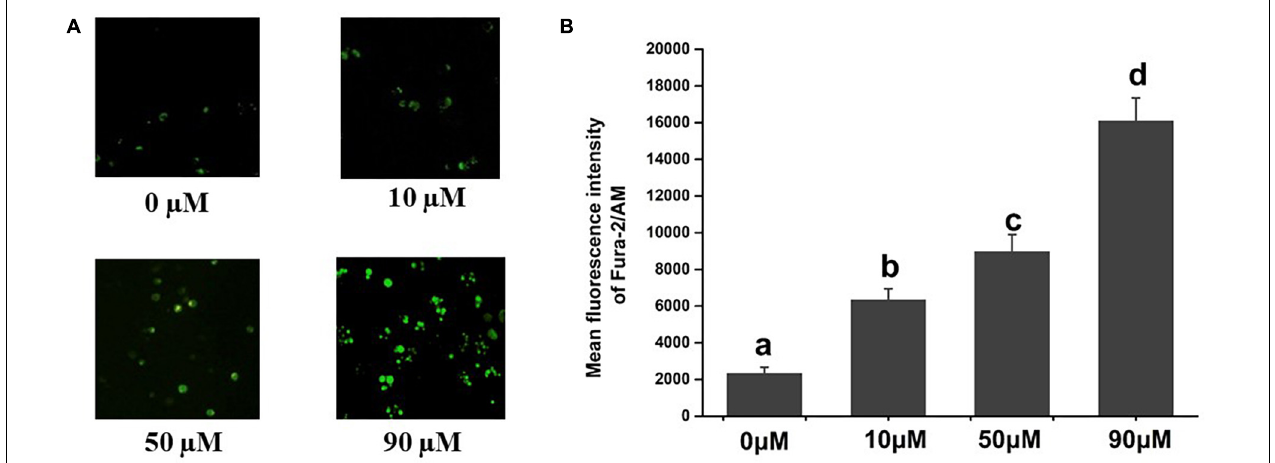
FIGURE 1 | Effects of scopoletin on intracellular free calcium [Ca 2 + ]i levels in insect Sf9 cells. 0, 10, 50, and 90 µ M indicate Sf9 cells incubated with scopoletin at concentrations of 0, 10, 50, and 90 µ M, respectively for 24 h. (A) The [Ca 2 + ]i level was detected by Fura-2/AM fluorescence staining. Positively stained calcium is shown as green zones in the captured images under a microscope. (B) The bar chart indicates the mean fluorescence intensity (MFI) of Fura-2/AM in Sf9 cells. Error bars represent the standard error of the calculated mean based on three biological replicates. Different letters on the error bars indicate significant difference according to Duncan’s multiple tests (alpha = 0.05). i.e., No statistical difference between “a” and “a”; significant difference among “a,” “b,” “c,” and